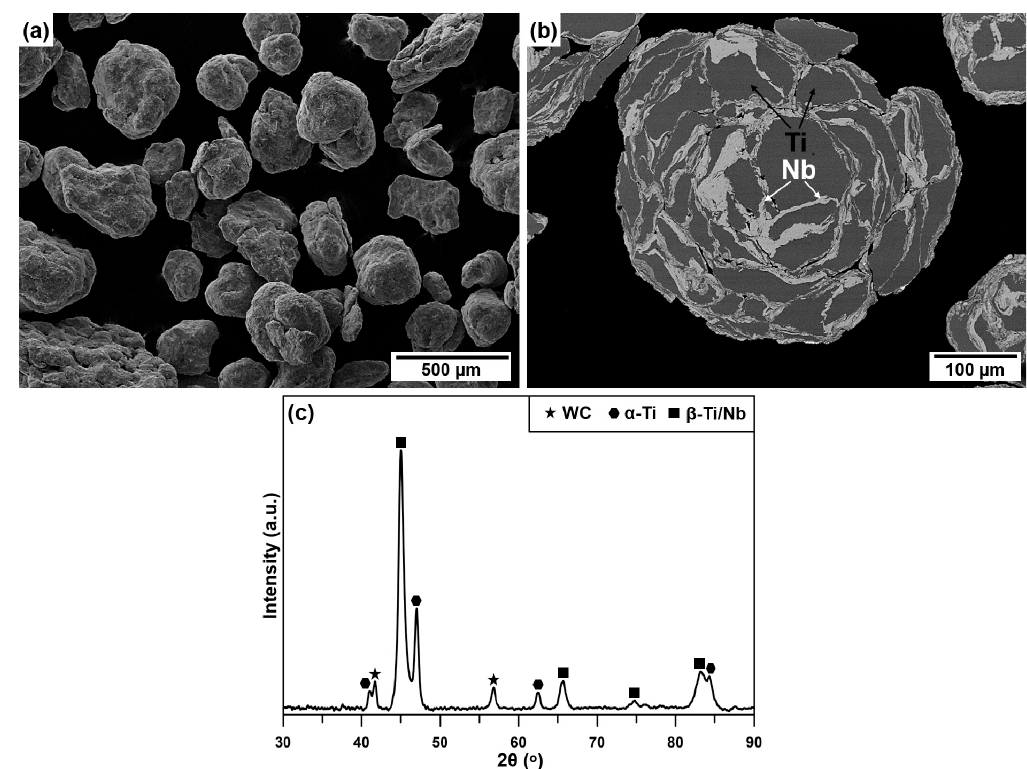
Figure 1. Typical SEM/SE ( a ) and SEM/BSE ( b ) micrographs of the powders after the MA on the example of the Ti-14Nb alloy and XRD pattern of this material ( c ).